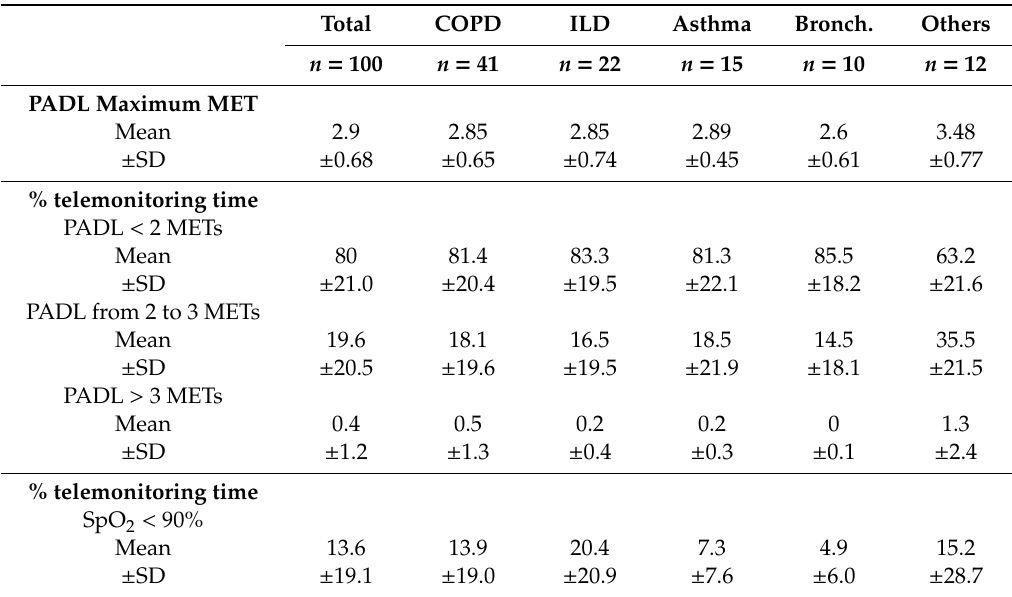
Table 3. Objective SMARTREAB PADL assessment per chronic respiratory